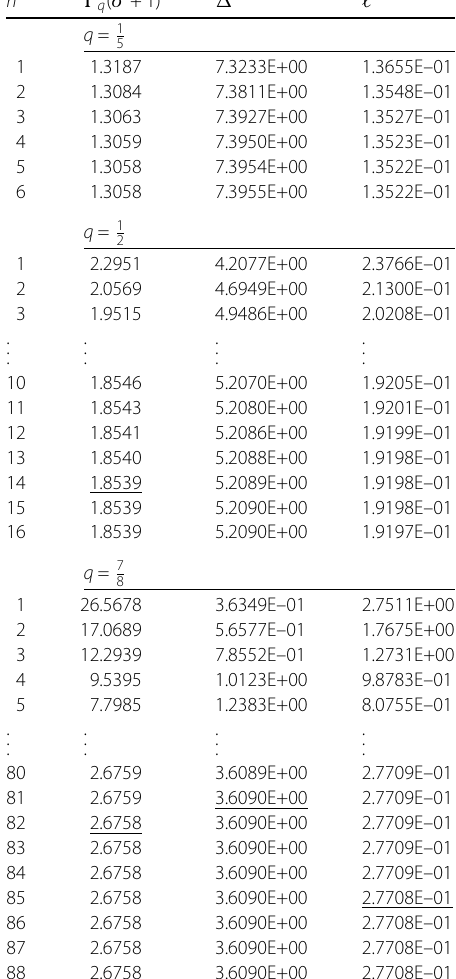
Table 3 Numerical results of (cid:7) q ( σ + 1), (cid:14) , and (cid:16)